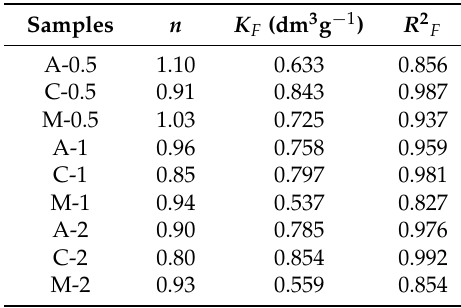
Table 2. Freundlich adsorption model fitting results for agarose only hydrogels (A),